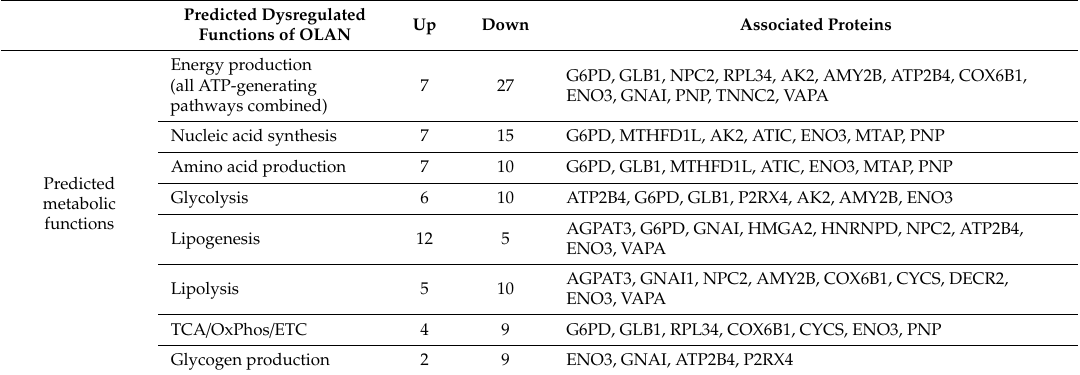
Table 2. Selected results from the KEGG function categories for di ff erentially expressed hepatic proteins from mice treated with